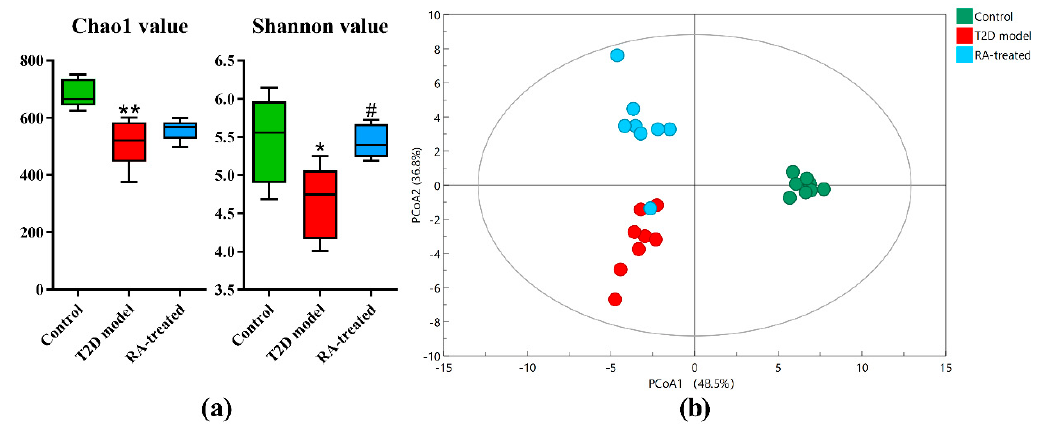
Figure 3. ( a ) The α -diversity of the Chao1 value and Shannon value for the control, T2D model and RA-treated groups. * p < 0.05 vs. control group; ** p < 0.01 vs. control group; # p < 0.05 vs. T2D model group by the Kruskal–Wallis test. ( b ) Principal coordinate analysis (PCoA) based on weighted unifrac metrics of the microbial community for the control, T2D model and RA-treated groups.